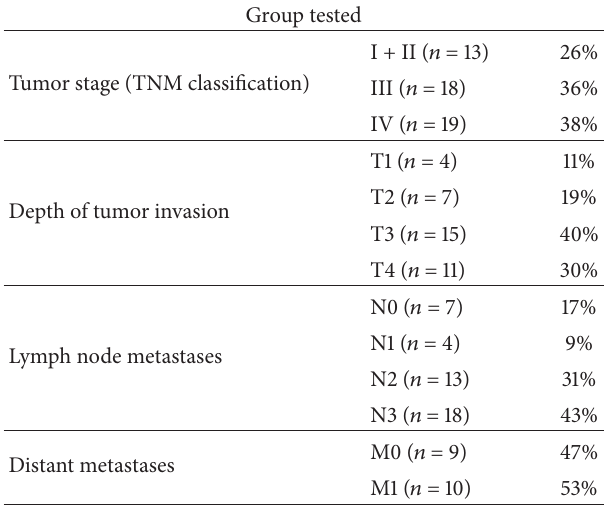
Table 1: The stage of gastric